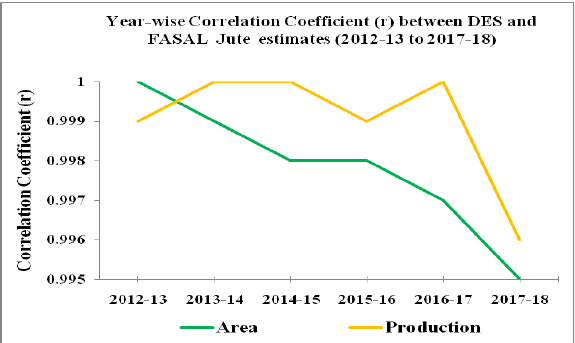
Figure13.DES and FASAL estimates comparison correlation coefficient (r) over the years